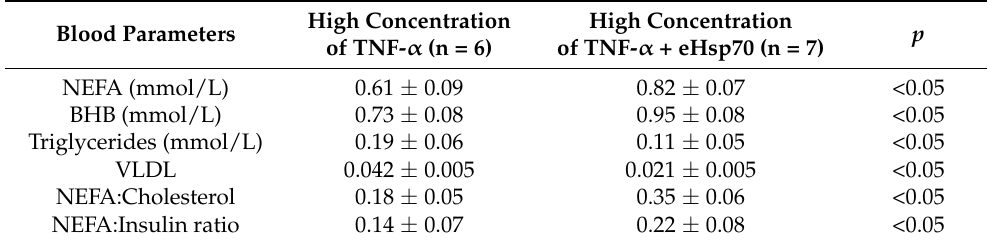
Table 3. Difference in blood parameters in cows with high concentration of TNF- α and cows with high concentration of TNF- α +